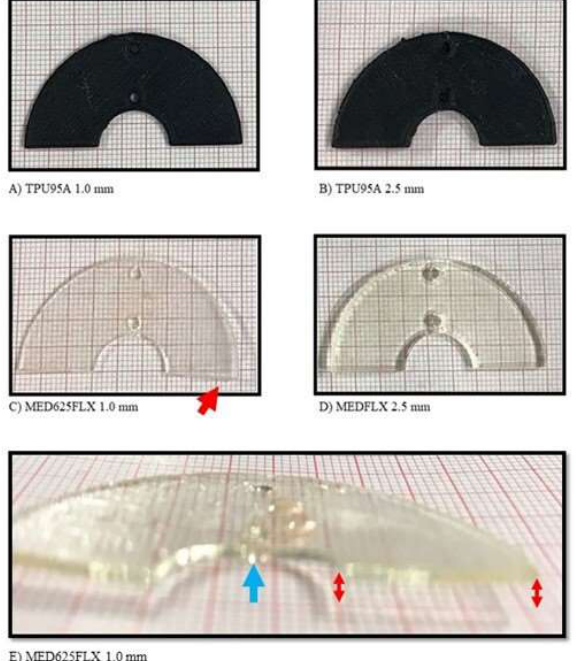
Figure 10. Repeatability of temperature measurements and error bars for TPU95A of 1.0 mm. Re- peatability of temperature measurements and error bars for TPU95A of 1.0 mm.